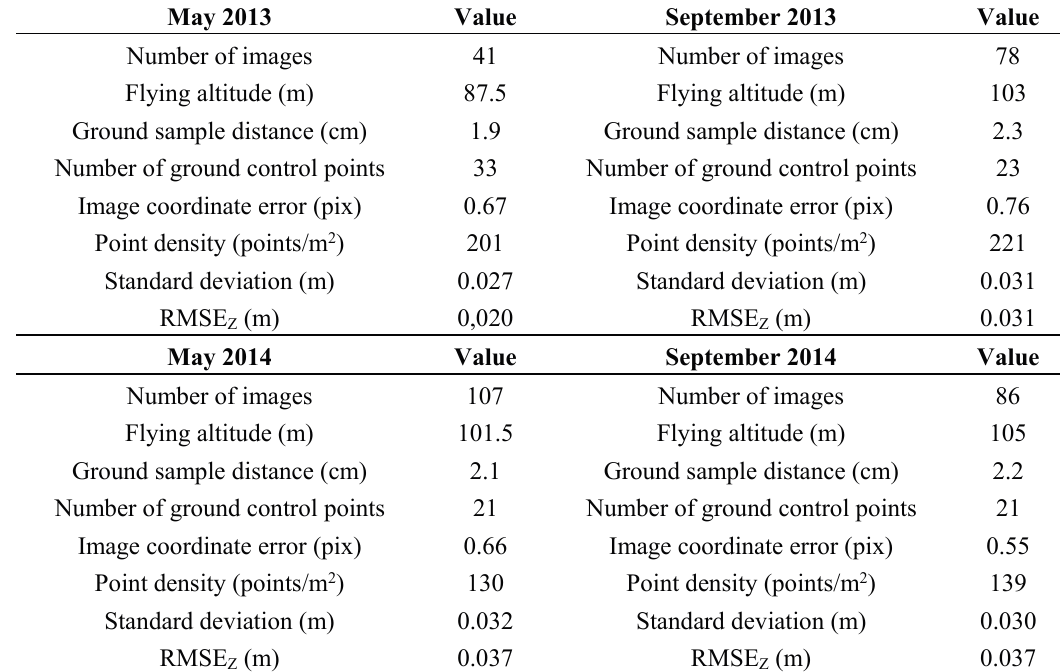
Table 4. Parameters of the imaging flight and image